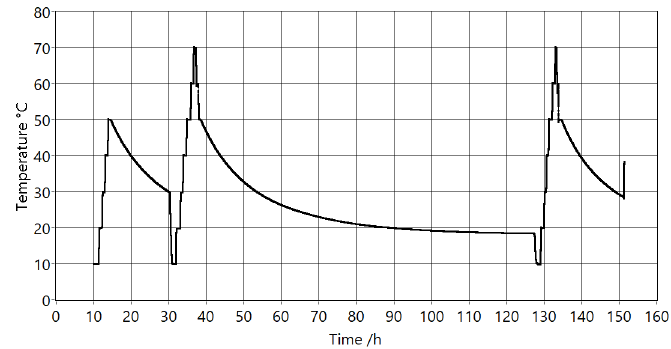
Figure 19. Temperature profile of the reference thermometer measurements during the evaluation.